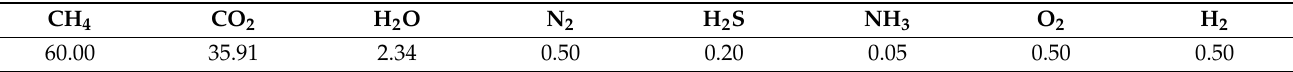
Table 3. Biogas composition, %